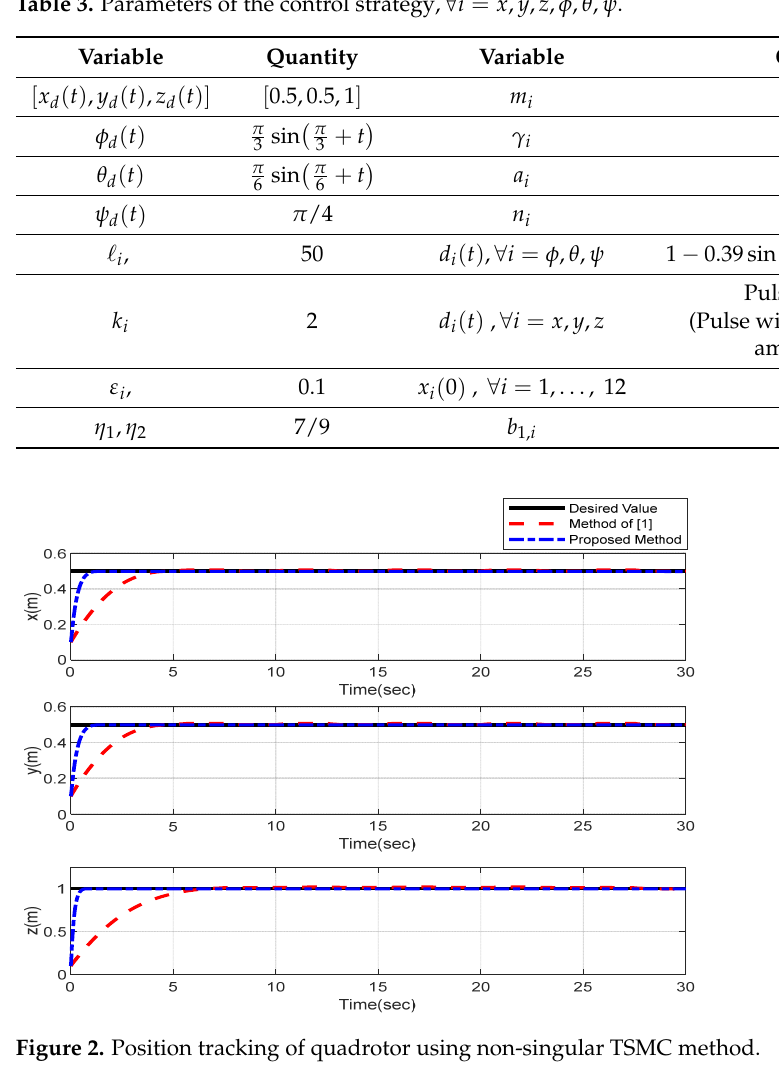
Figure 4. Trajectories of position tracking errors .